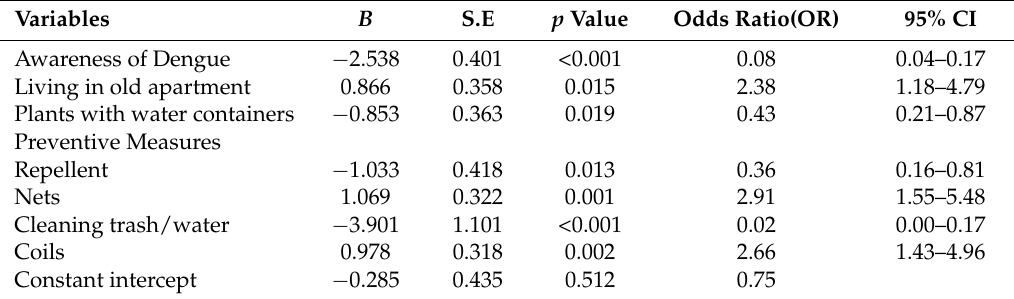
Table 2. Logistic regression model results for predictors of Dengue Fever infection in the 2014 Guangzhou